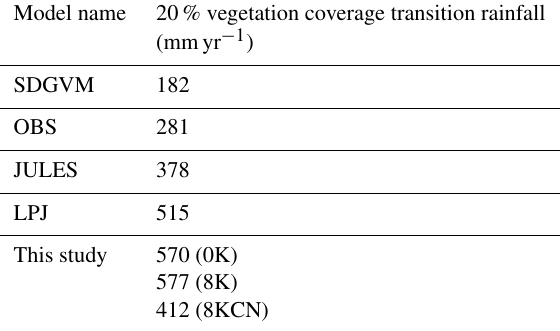
Table 3. The 20% vegetation coverage transition rainfall for OBS (observation data) and four model simulations (the Joint UK Land Environment Simulator version 4.1, Lund–Potsdam–Jena dy- namic vegetation model version 2.1, Sheffield Dynamic Global Vegetation Model, and CLM4 for this study). OBS, JULES, LPJ, and SDGVM indicate the value from the observation and model simulation in the pre-industrial conditions, which is from Hopcroft et al.